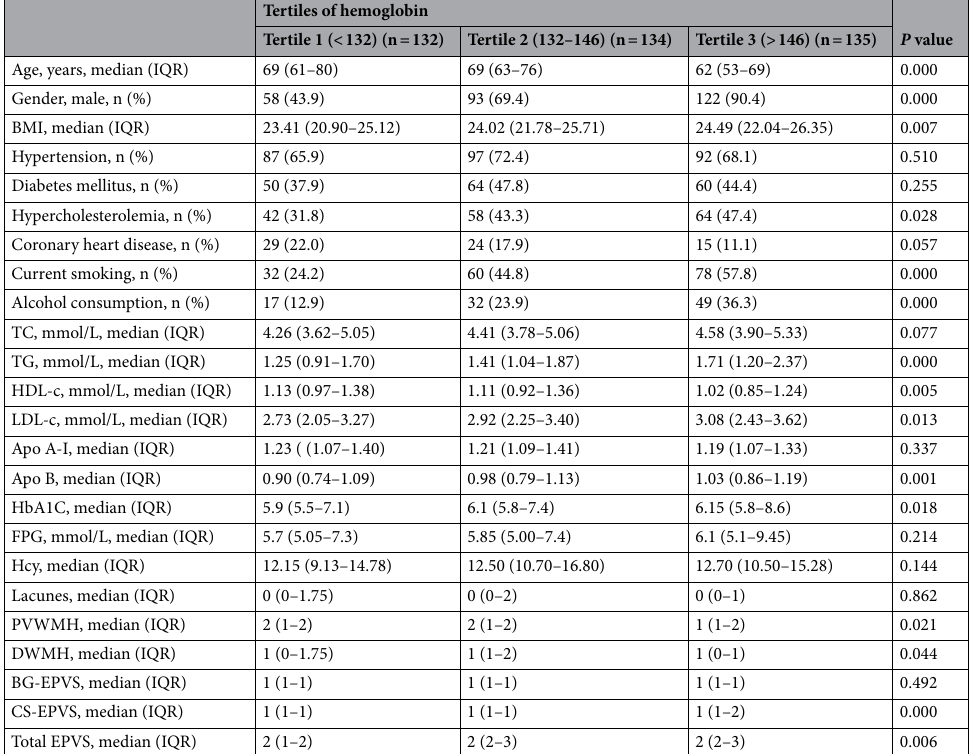
Table 2. Characteristics of study population grouped by tertiles of hemoglobin. IQR interquartile range, BMI body mass index, TC total cholesterol, TG triglyceride, LDL-c low-density lipoprotein cholesterol, HDL-c